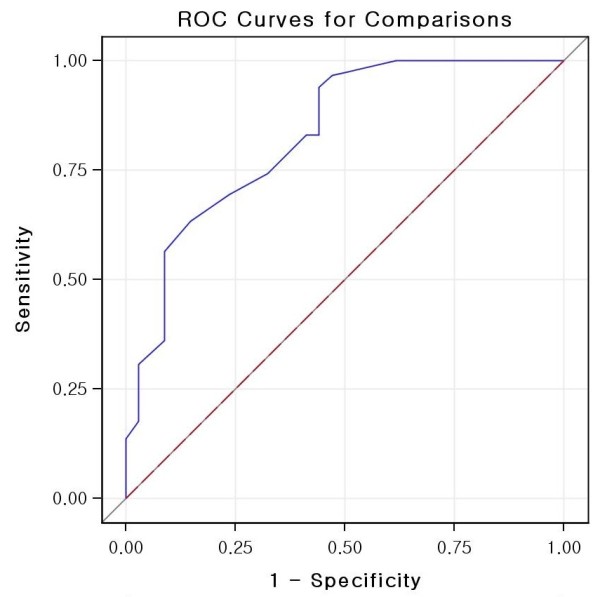
Receiver operating characteristic (ROC) curve for maximal metastatic node size and capsular invasion in the prediction of solitary lateral neck metastasis.